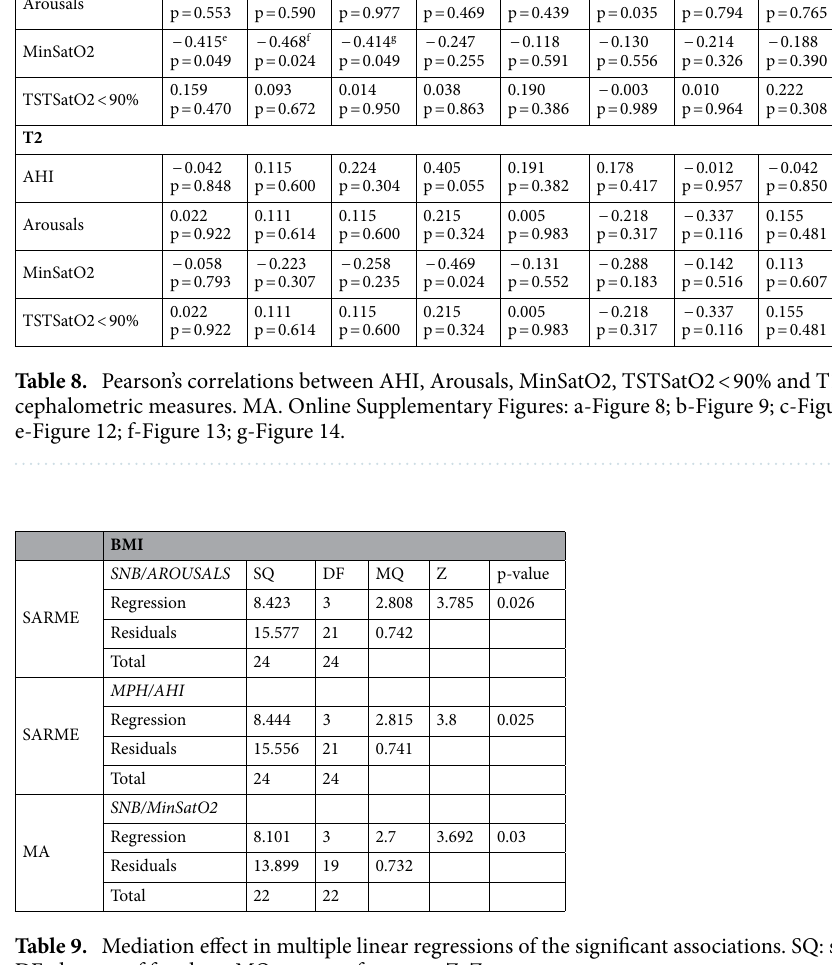
Table 9. Mediation effect in multiple linear regressions of the significant associations. SQ: sums of the squares; DF: degrees of freedom; MQ: means of squares; Z: Z-score.